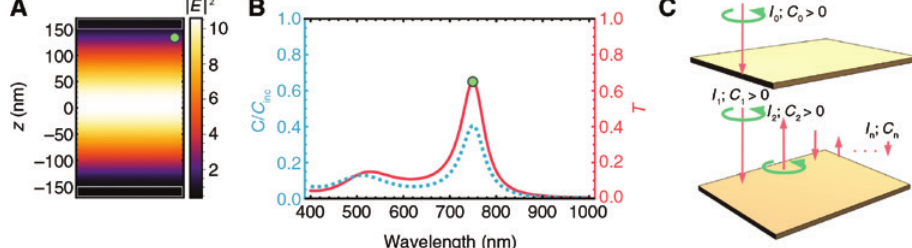
Figure 3: Limitation of optical chirality in planar isotropic cavities. (A) Electric field enhancement inside an empty 300 nm thick cavity induced by a normally incident plane wave at a wavelength of 750 nm corresponding to the first order Fabry-Pérot resonance. (B) Spectrum of normalized chirality density C / C wave inside a 300 nm thick Fabry-Pérot cavity formed by 20 nm thick Au mirrors. (C) Illustration of chirality density limitation inside isotropic planar cavities: an incident CP plane wave experiences a series of reflections inside the cavity, reversing its handedness each